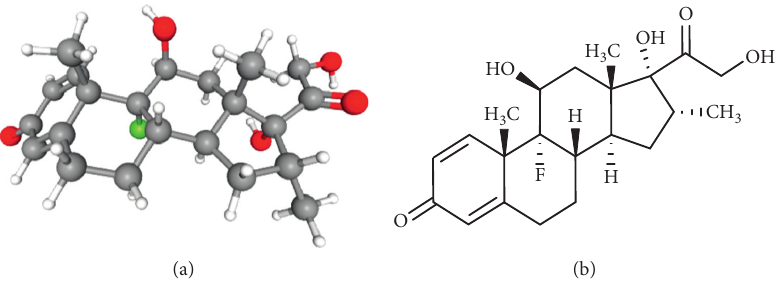
Figure 1: Molecular structure of dexamethasone: (a) 3D structure; (b) 2D